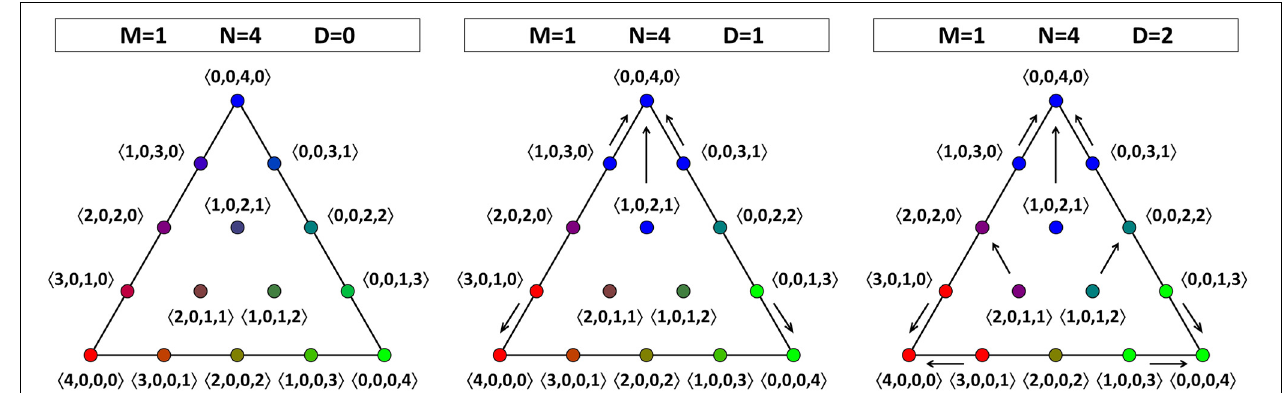
FIGURE 5 | Opinion dynamics for theories in a language with one atomic proposition ( M = 1) and a population consisting of four agents ( N = 4). We show the same face of the OPS for D = 0 (left), D = 1 (middle), and D = 2